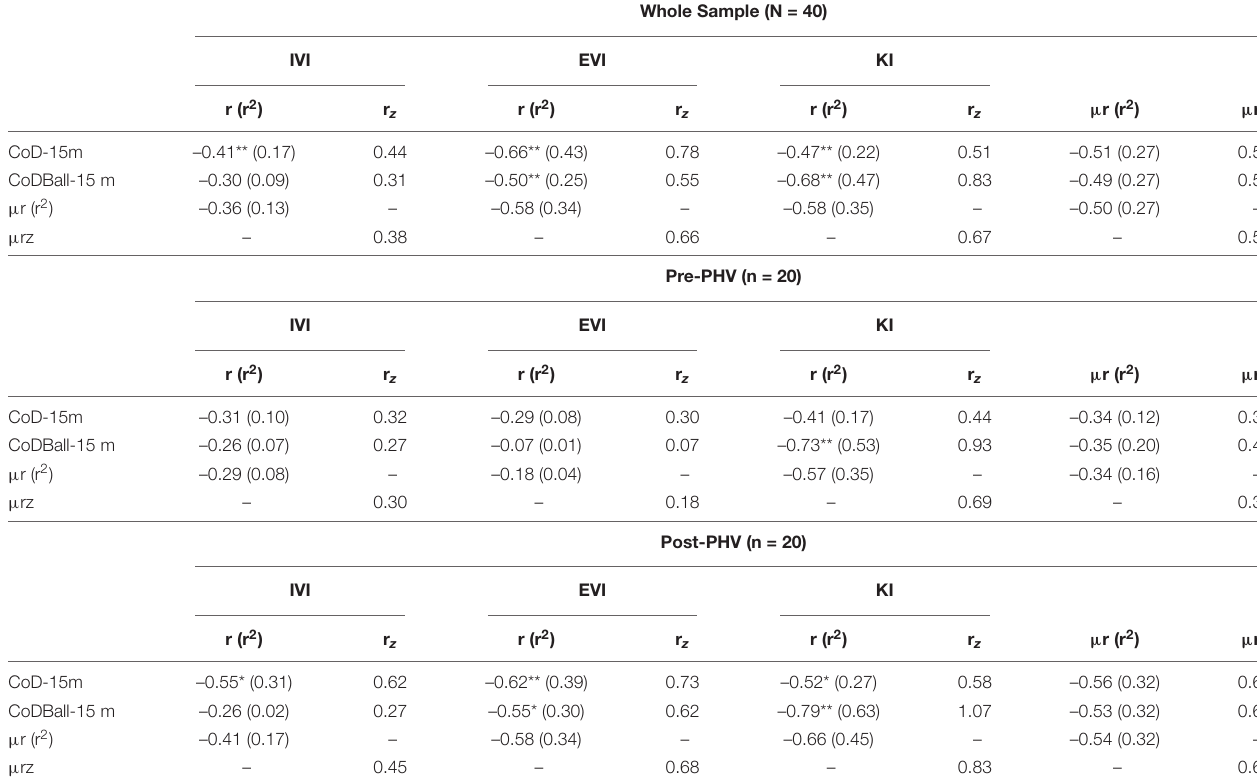
TABLE 3 | Correlations between studied variables in forty elite youth soccer players according to their maturity status (pre-PHV and